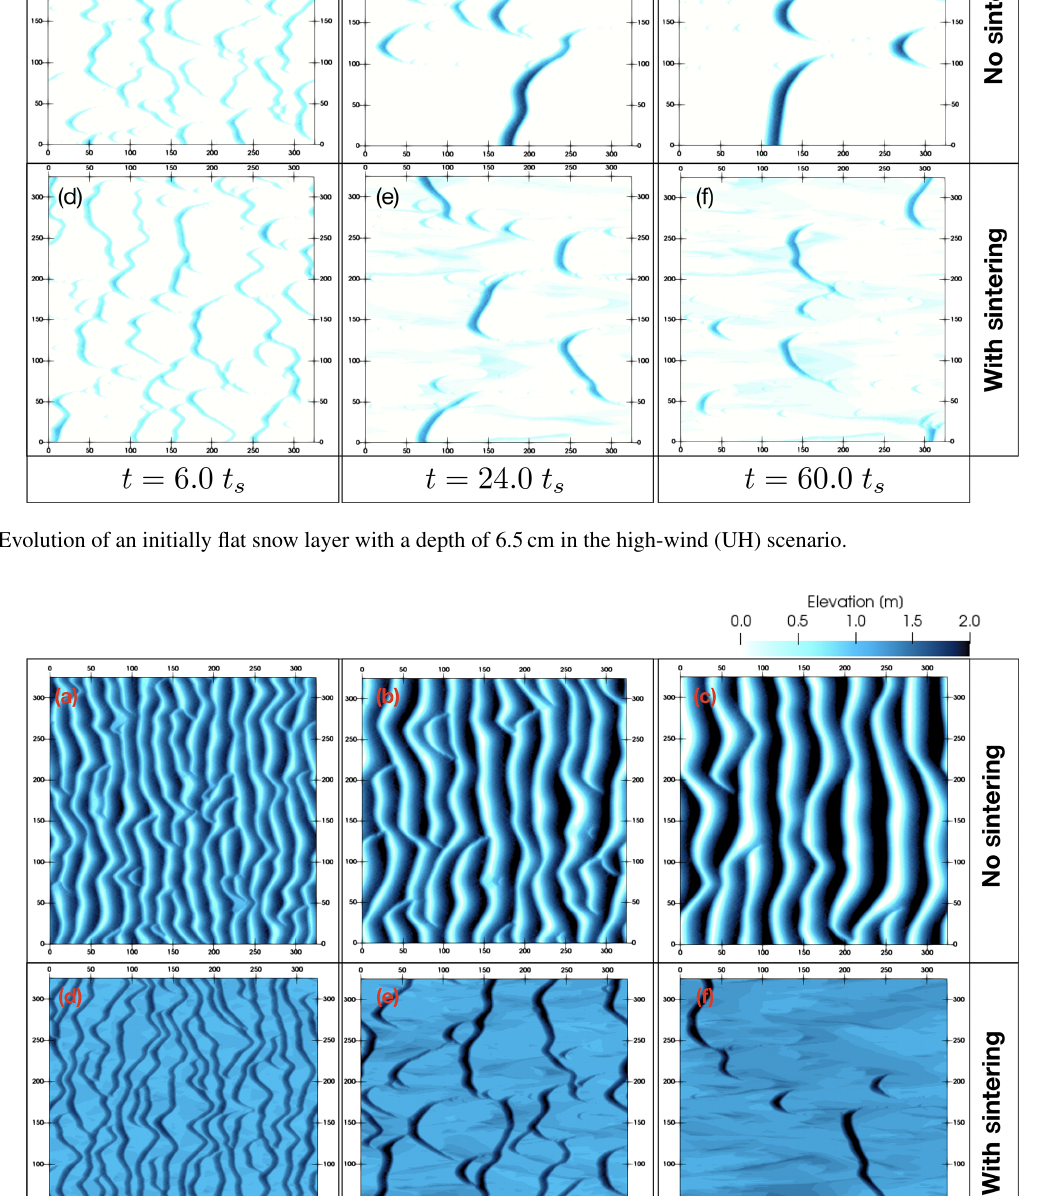
The Cryosphere, 13, 3239–3260, 2019